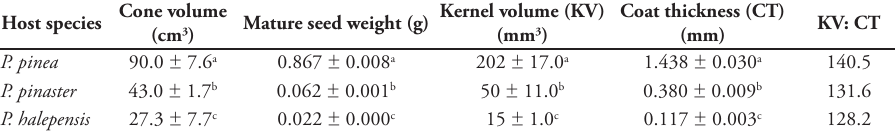
Table1. Cone and seed average measures ( ± SE) of the three host species. Different letters within a col- umn indicate significant differences between the values per host species after ANOVA tests (p-value=0.05) followed by SNK